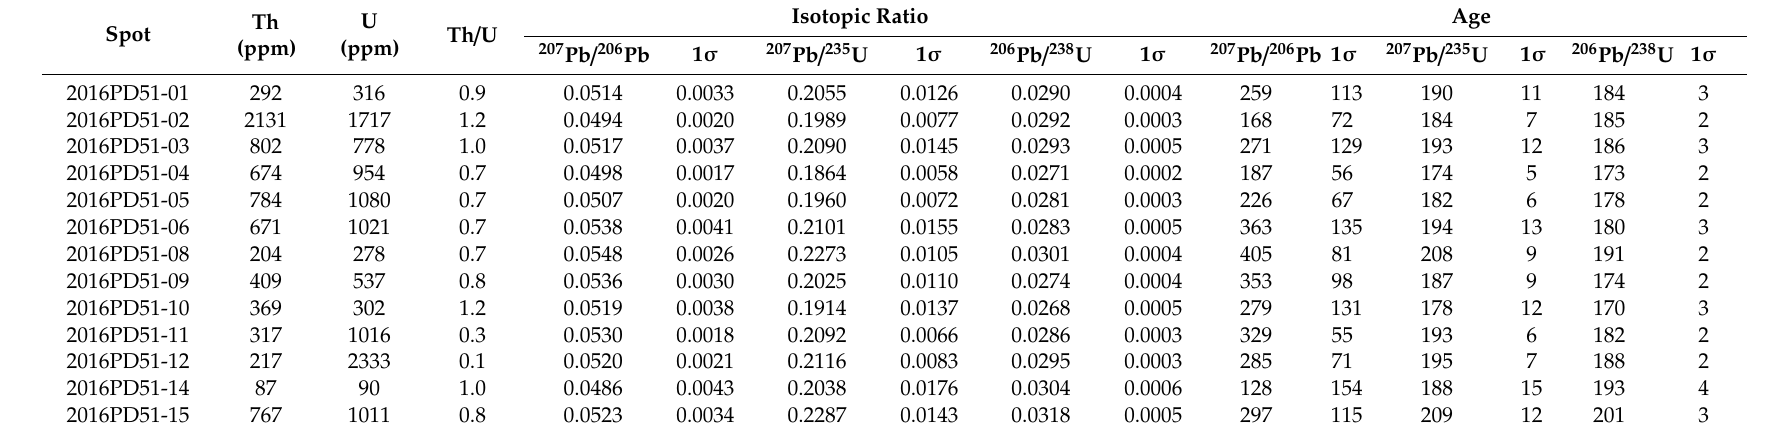
Table A2. Rare earth elements composition (ppm) of zircon in Jijal chromitite.